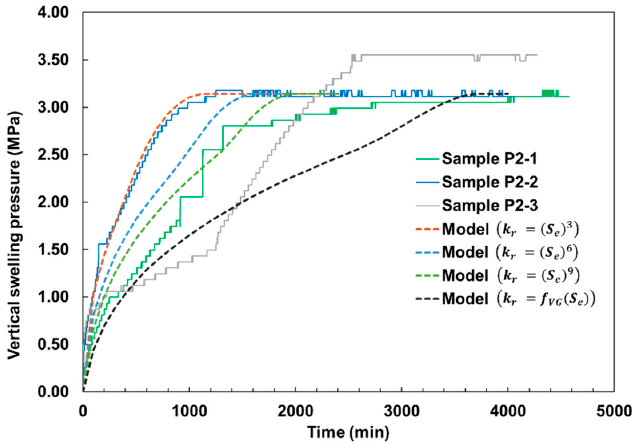
Figure 5. Swelling pressure evolution for different models of material relative permeability.